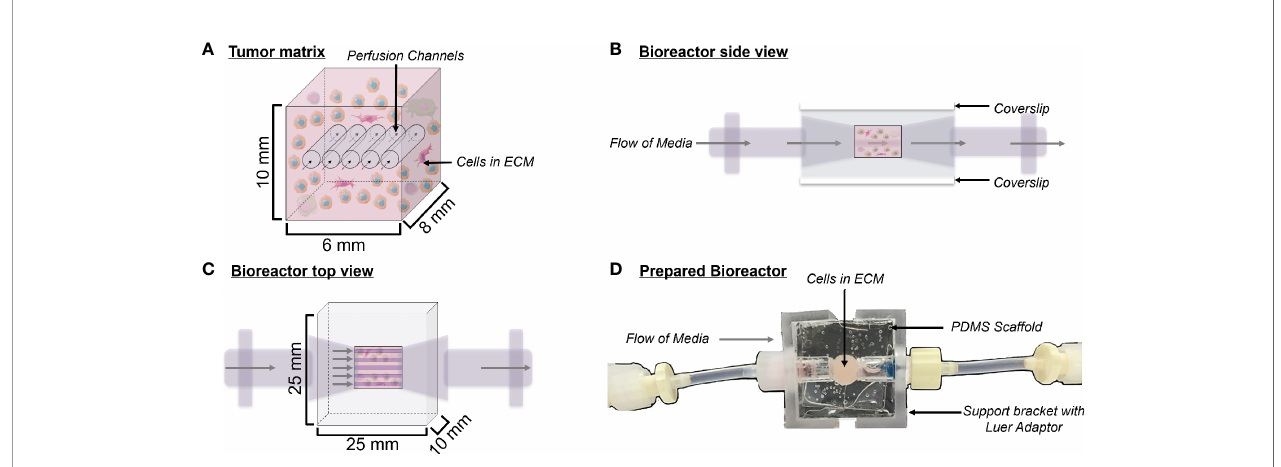
FIGURE 1 | Bioreactor design. (A) Schematic depicting a cross-section of the tumor matrix volume, containing cells within an extracellular matrix (light pink) pierced by fi ve perfusion channels. Flow of media through these channels is indicated by arrows. The composition of the surrogate ECM includes Matrigel, collagen (type 1 bovine), DMEM, sodium bicarbonate, cancer cells, and stroma. (B) Side view schematic of the bioreactor with cells in culture, showing coverslips on the top and bottom surfaces, which allow for non-invasive imaging during culture. (C) Top view schematic of the bioreactor with cells in culture. (D) Top view photograph of the polydimethylsiloxane bioreactor fi nal product. Support brackets on each side attach to Luer fi ttings and hold guide wires leading to the perfusion channels within the tumor